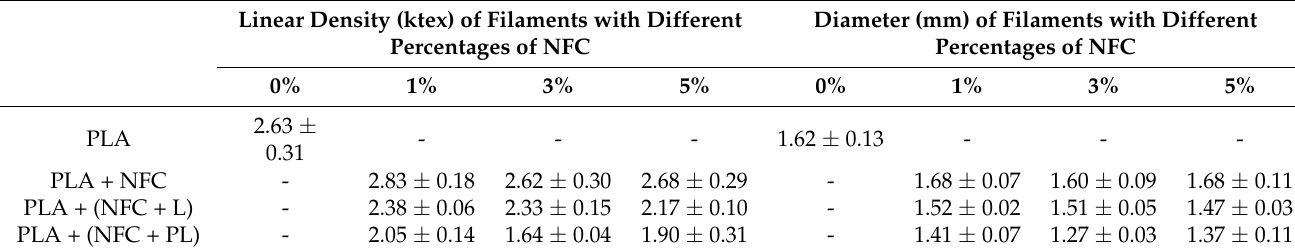
Table 1. Linear density and diameter of filaments; mean value ±